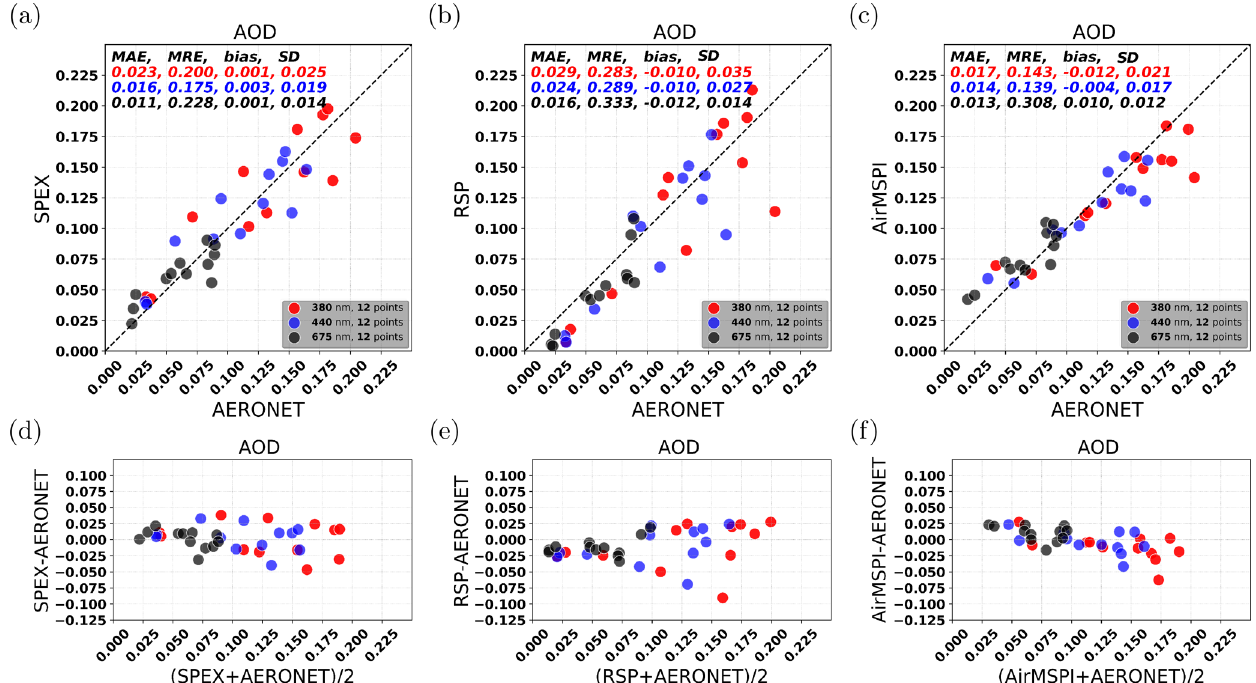
Figure 1. Comparison with AERONET for AOD (380, 440, and 675nm) among SPEX, RSP, and AirMSPI retrievals. (a, b, c) SPEX, RSP, and AirMSPI comparison with AERONET, respectively. (d, e, f) Bland–Altman plots (or difference plots) between SPEX and AERONET, between RSP and AERONET, and between AirMSPI and AERONET, respectively.